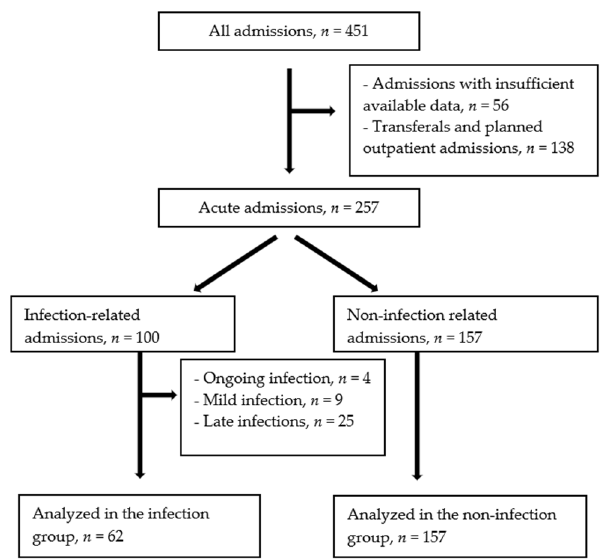
Figure 1. Included and excluded admissions during the one year study period.